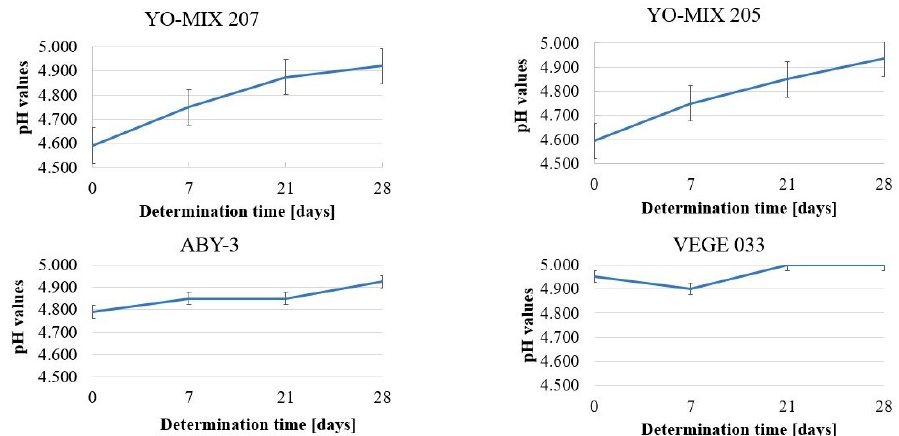
Figure 3. pH values of buckwheat beverages during refrigerated storage (mean values and standard deviations, n = 3).